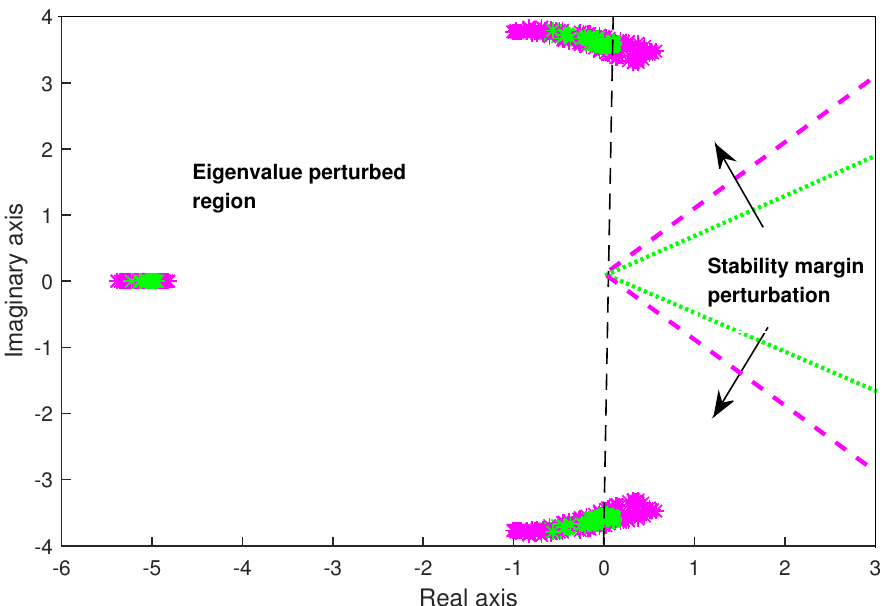
Figure 1. Eigenvalue perturbed region of system (2) in Example 1 with ν ( σ ) ∈ [ 0.4,0.8 ] . For system (2) with order ν ( σ ) = 0.6, the stability region B ε is depicted in Figure 2. The simulation result of Example 1 with initial condition x ( 0 ) = [ − 0.03 − 0.03 0.03 ] T ∈ B ε is depicted in Figure 3. System (2) is stabilized by the state feedback controller in about 0.2 s.